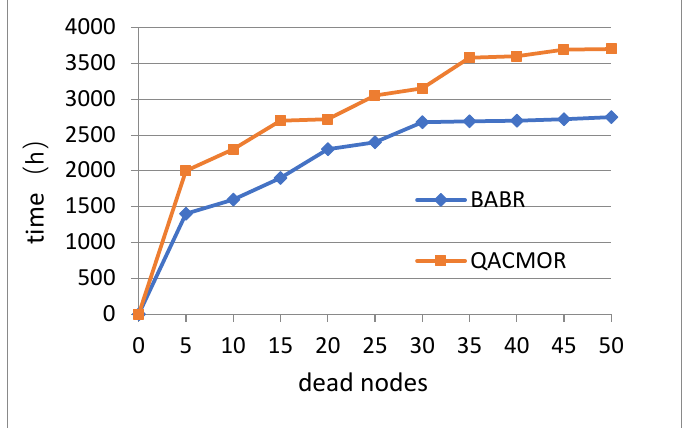
Figure 8. Time vs. number of dead nodes.